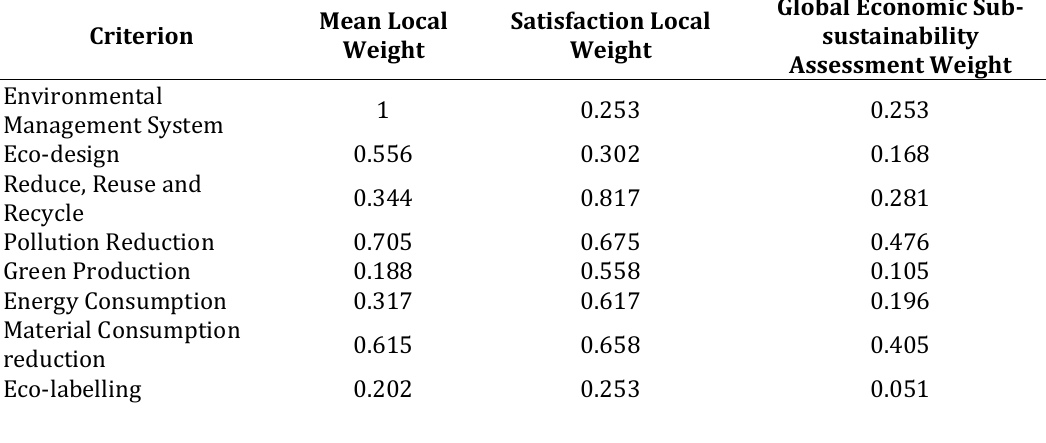
Table 3: Index weight and global weights of environment sub-sustainability assessment, macro-scale literature based